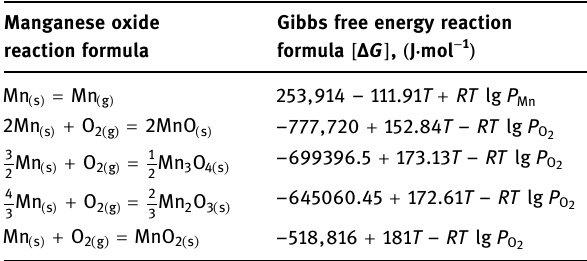
Manganese oxide reaction formula